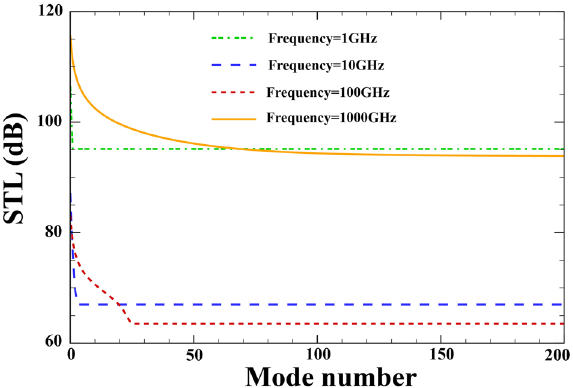
Figure 2. Mode convergence diagram.